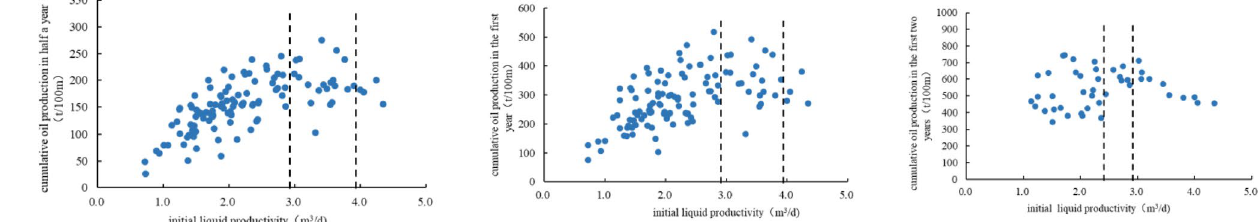
Figure 10. Relationship between initial liquid productivity and cumulative oil production per hundred-meter oil-bearing lateral length in different